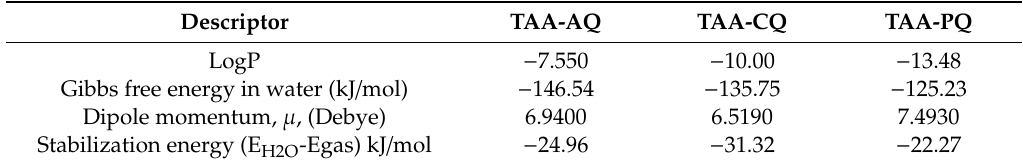
Table 5. Quantitative structure–activity relationship (QSAR) properties of complex TAA-antimalarial, in water